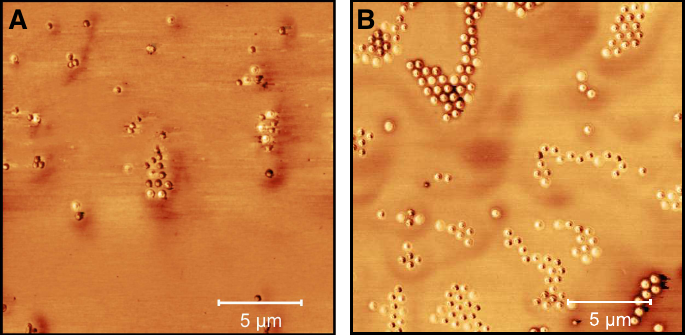
Figure 13. AFM phase images (20 × 20 µ m) of microgel particles loaded with CBD ( c CBD = 25mg/mL) in water ( A ) and after the release of CBD in water (with removed supernatant and redispersion in water) ( B ). The images were recorded at room temperature in the dried state on PEI-coated silicon